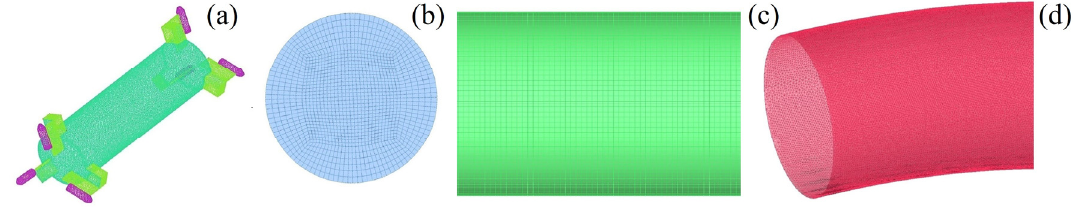
Figure 5. Grid diagram of each part: ( a ) mesh of the wheeled capsule; ( b ) mesh of the interface between the straight and the bend pipes; ( c ) structured mesh of the straight pipe; ( d ) unstructured mesh of the bend pipe.